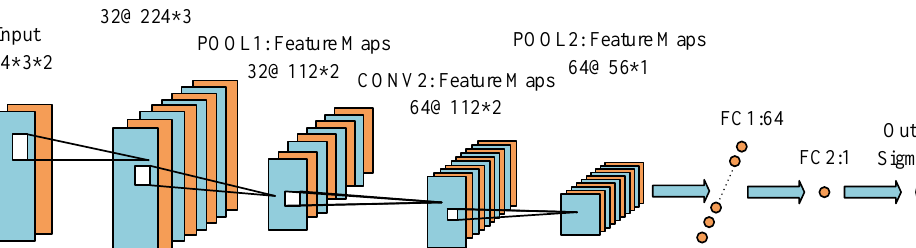
Figure 4. Structure of the ZUPT point selection model. In order to extract features from the last con- volutional layer, the numbers of the first and second convolutional kernels are 32 and 64,